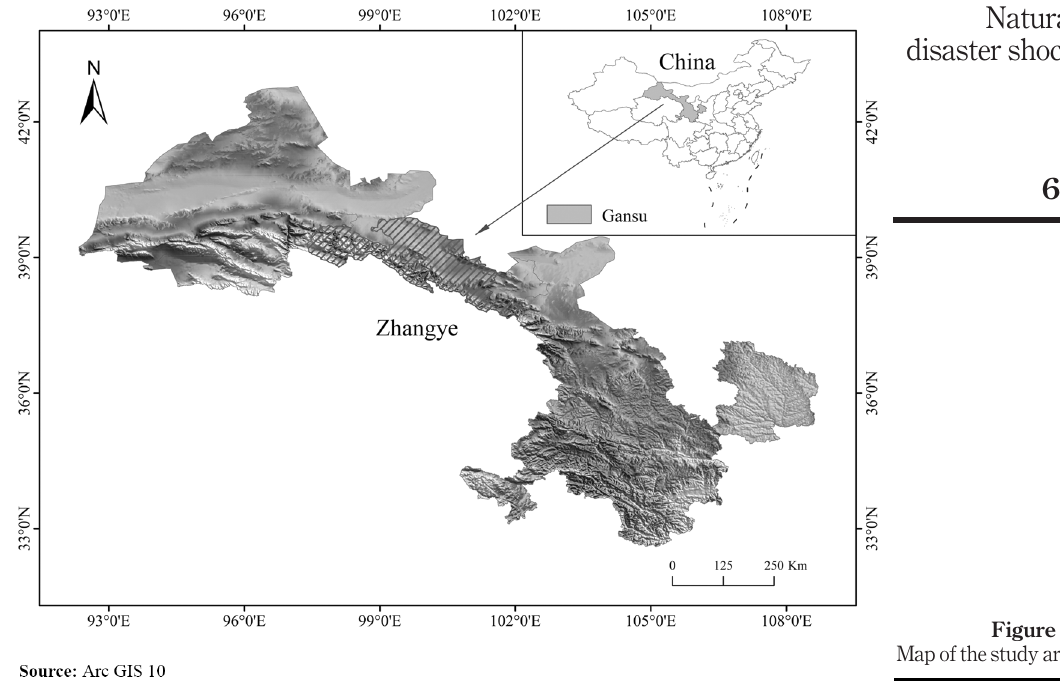
Figure 2. Map of the study